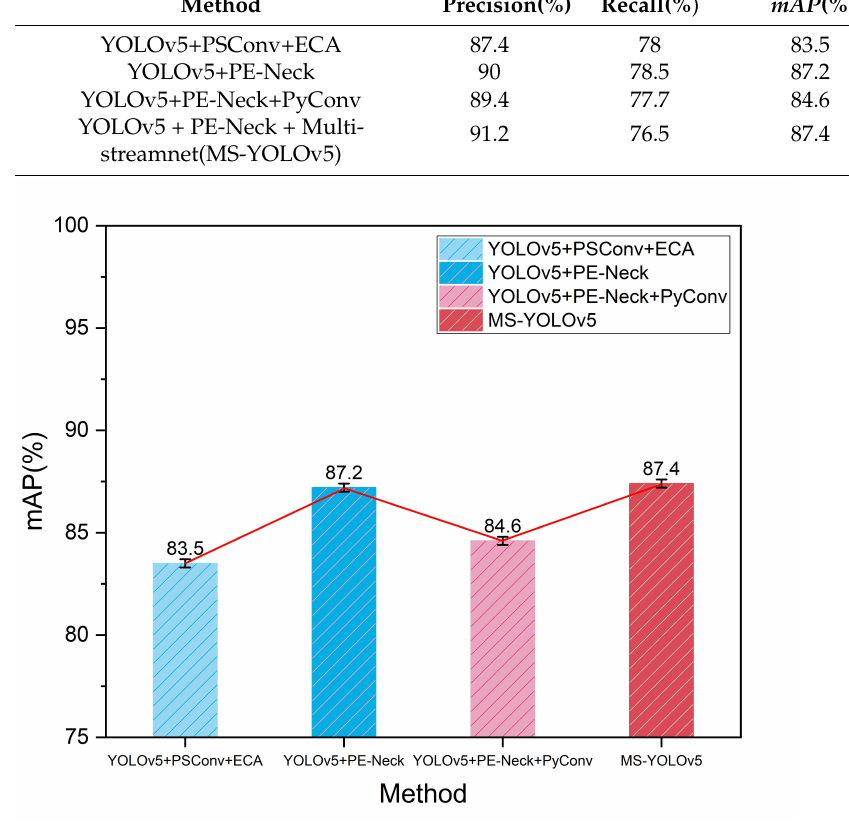
Figure 14. Comparison of mAP with the original module and with the improved